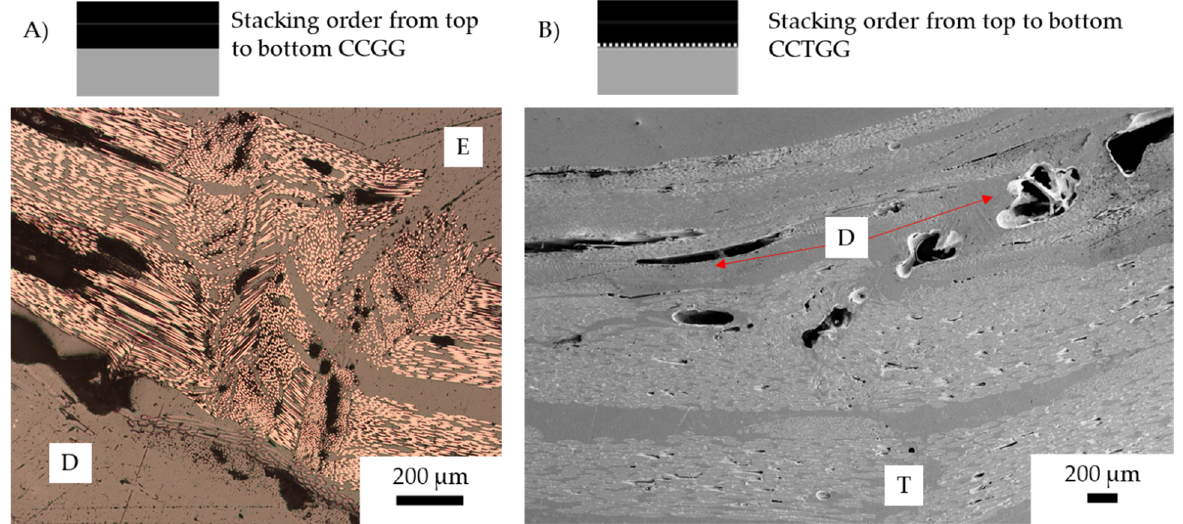
Figure 19. Post-failure micrographs of carbon/glass hybrid fibre samples after three-point bending: ( A ) CCGG, ( B ) CCTGG. Annotation: E (elastic buckling), T (tension rupturing), and D (Delamination). Fibre direction shown with red arrow.